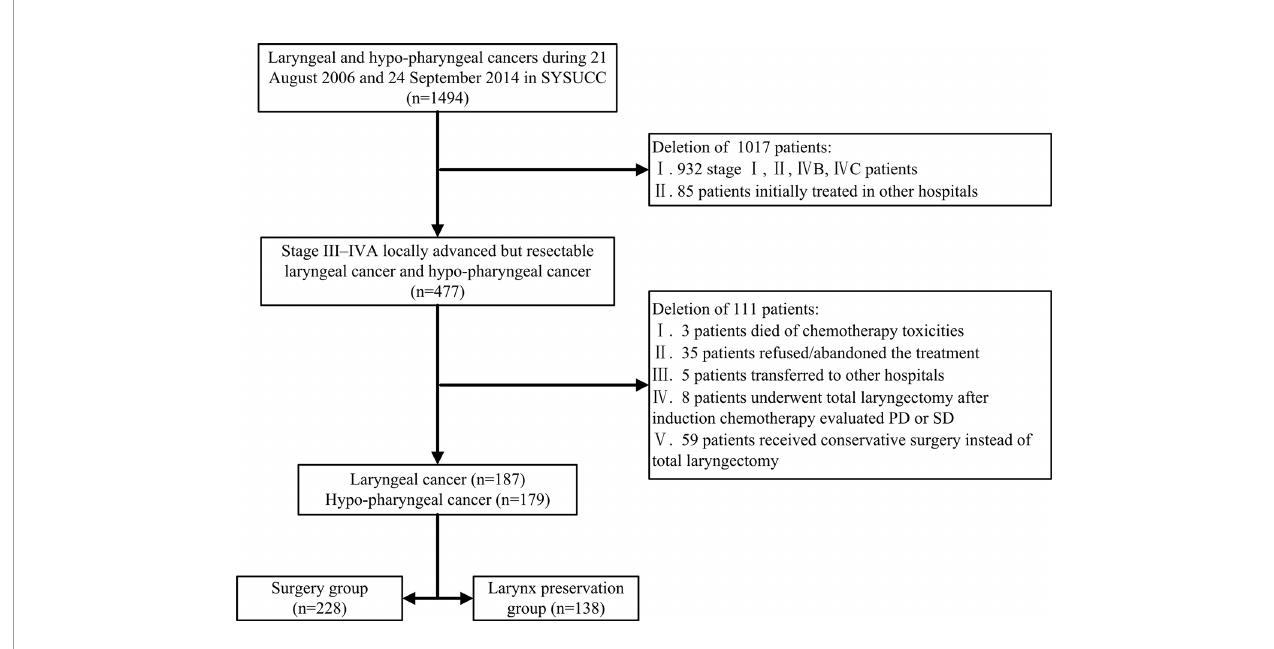
FIGURE 1 | Screening fl owchart for eligible